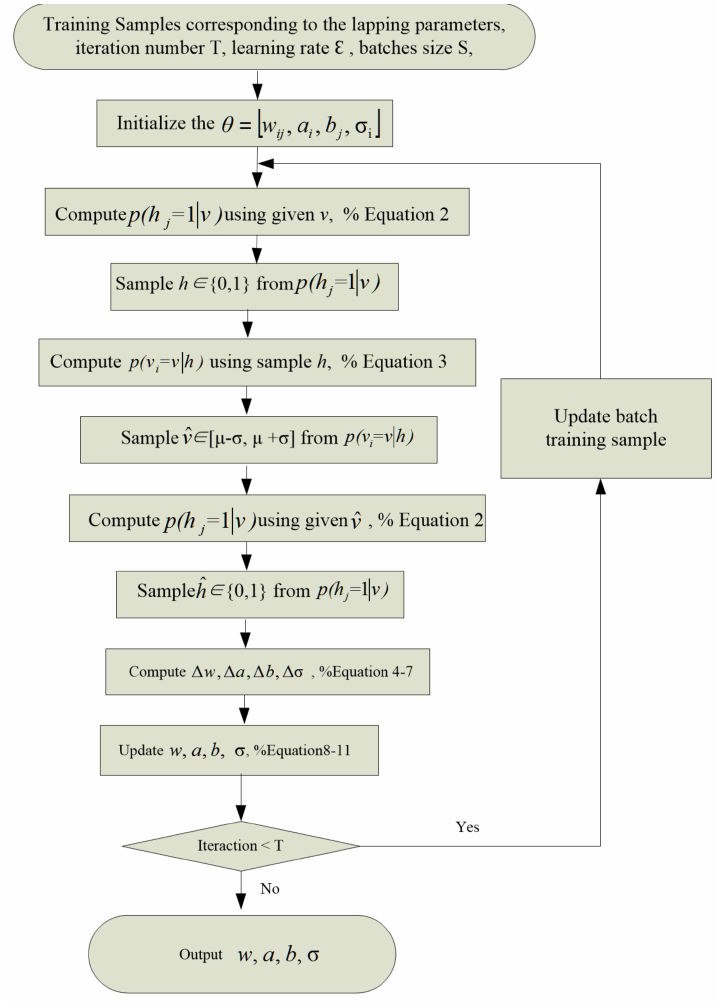
Figure A2. The pre-training process by